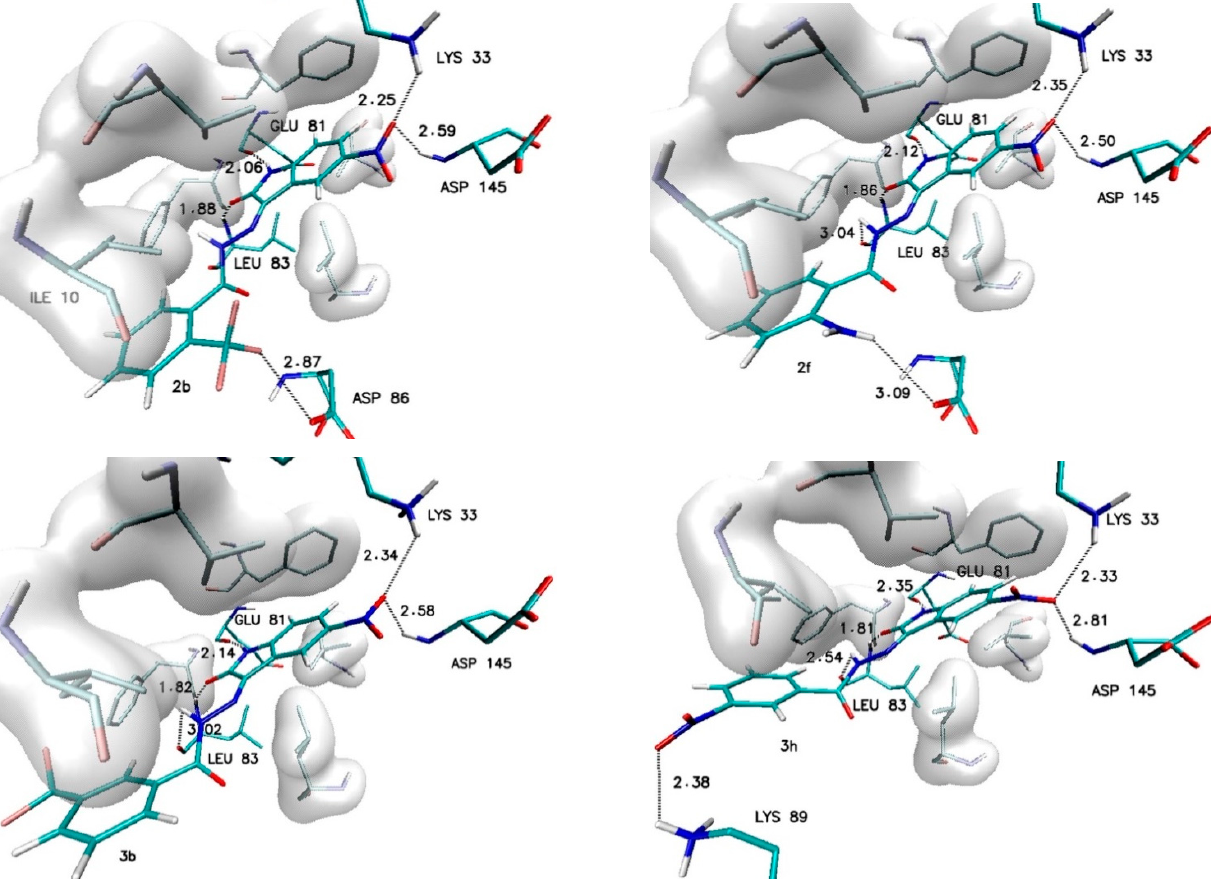
Figure 4. The graphic representation of interactions involved in stabilization of CDK2 complex with chosen 5-nitroisatin-based benzoylhydrazines. Table 3. The values of hydrogen bond lengths [Å] involved in stabilization of 5-nitroisatin-based benzoylhydrazines complexes with the CDK2 active